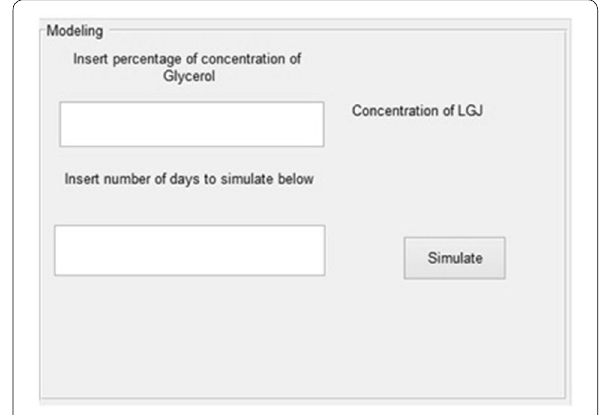
Fig. 5 The prediction stage